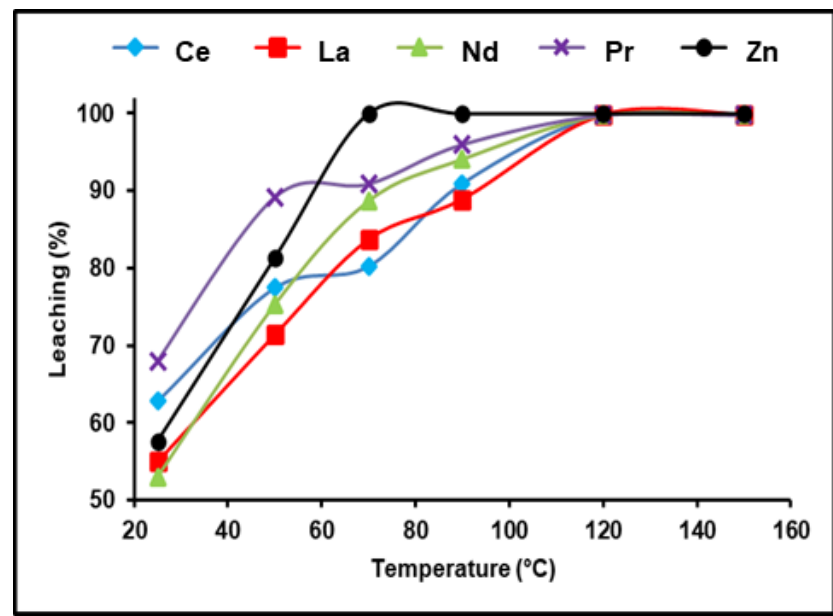
Figure 5. Influence of temperature on the dissolution of REEs and Zn from spent Ni–MH battery powder (300 g/L (NH 4 ) 2 SO 4 , t: 180 min, 1:3 (S/L) ratio).